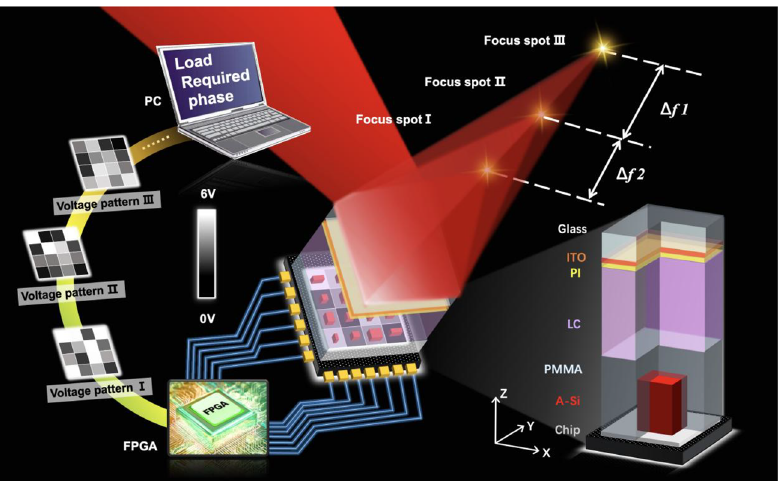
Figure 1: Schematic illustration of the LC nonmechanical varifocal metalens. The metasurface coated by PMMA and the electrically controllable LC layer function as two complementary phase plates for the Moiré lens. By loading different two-dimensional voltage patterns on the analog chip, the focal length of the reflected light can be adjusted